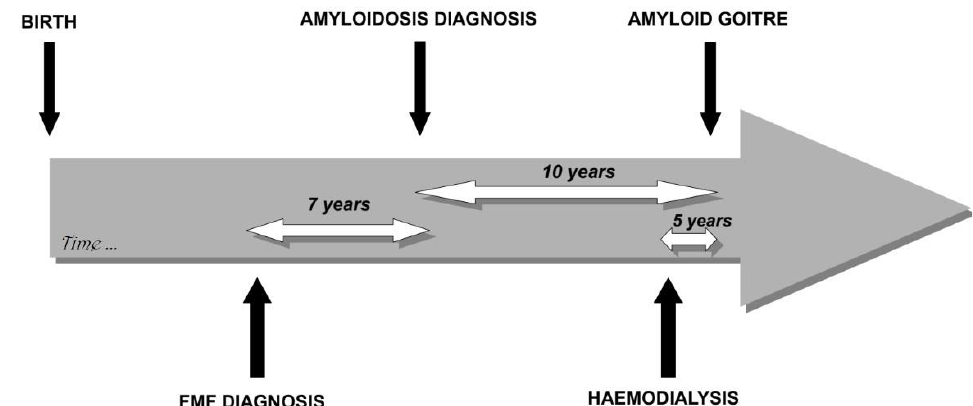
Figure 2. Proposed timeline for the development of amyloid goiter. The white arrows represent the median duration, in years, between each medical event indicated by a black arrow.